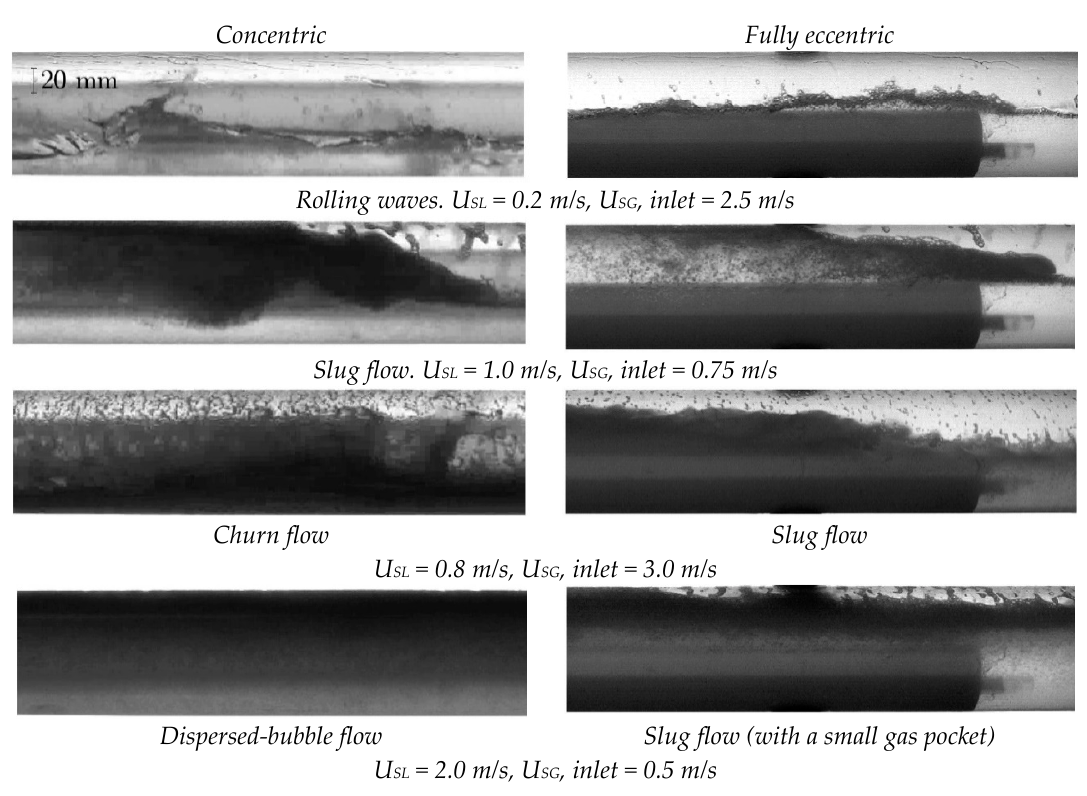
Figure 1. Flow regimes observed in a horizontal annulus during the experimental campaign. Adapted from [1].